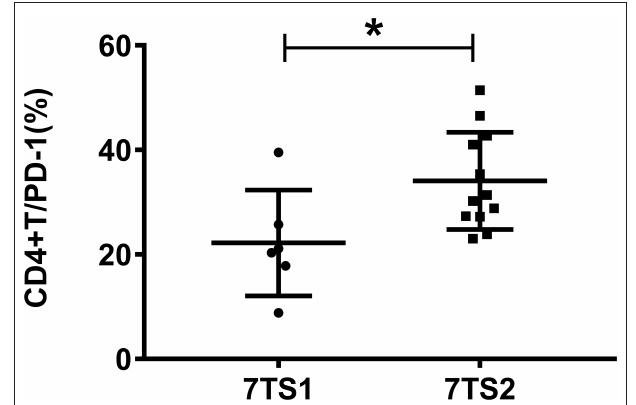
FIGURE 1 | The figure shows the expression of PD-1 on CD4 + T cells between the 7-day death group (7TS1) and the survival group (7TS2). The expression of PD-1 in the 7-day death group was lower than that in the survival group ( P < 0.05), and the difference was statistically significant. * P <